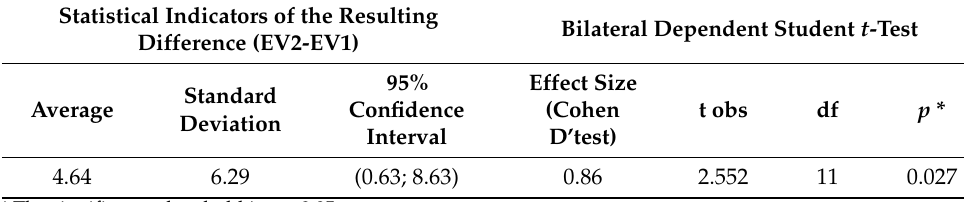
Table 7. The table of statistical indicators of the difference in percentage distribution of weight on the left leg.